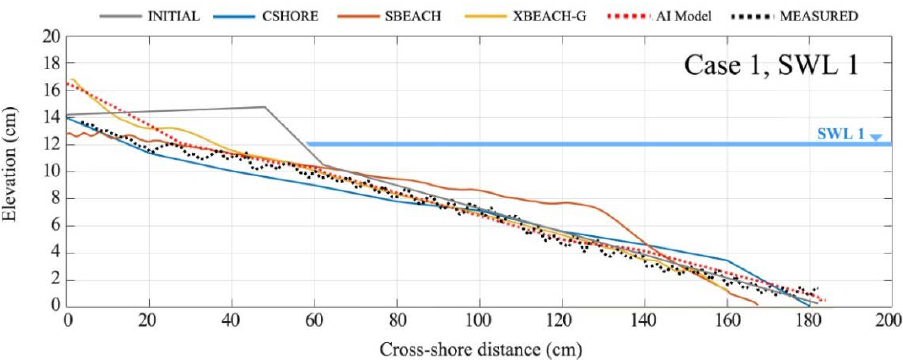
Figure 22. Case 1 SWL 1 comparison of the numerical simulations and the ANN model.